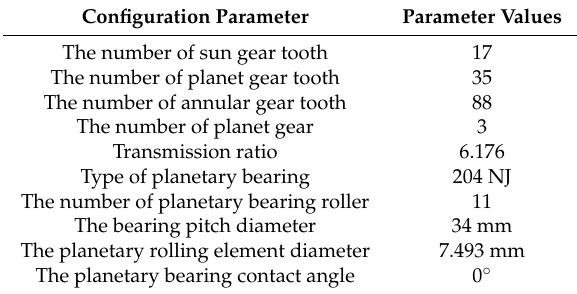
Table 1. Parameters for planetary gearbox and planetary bearing.